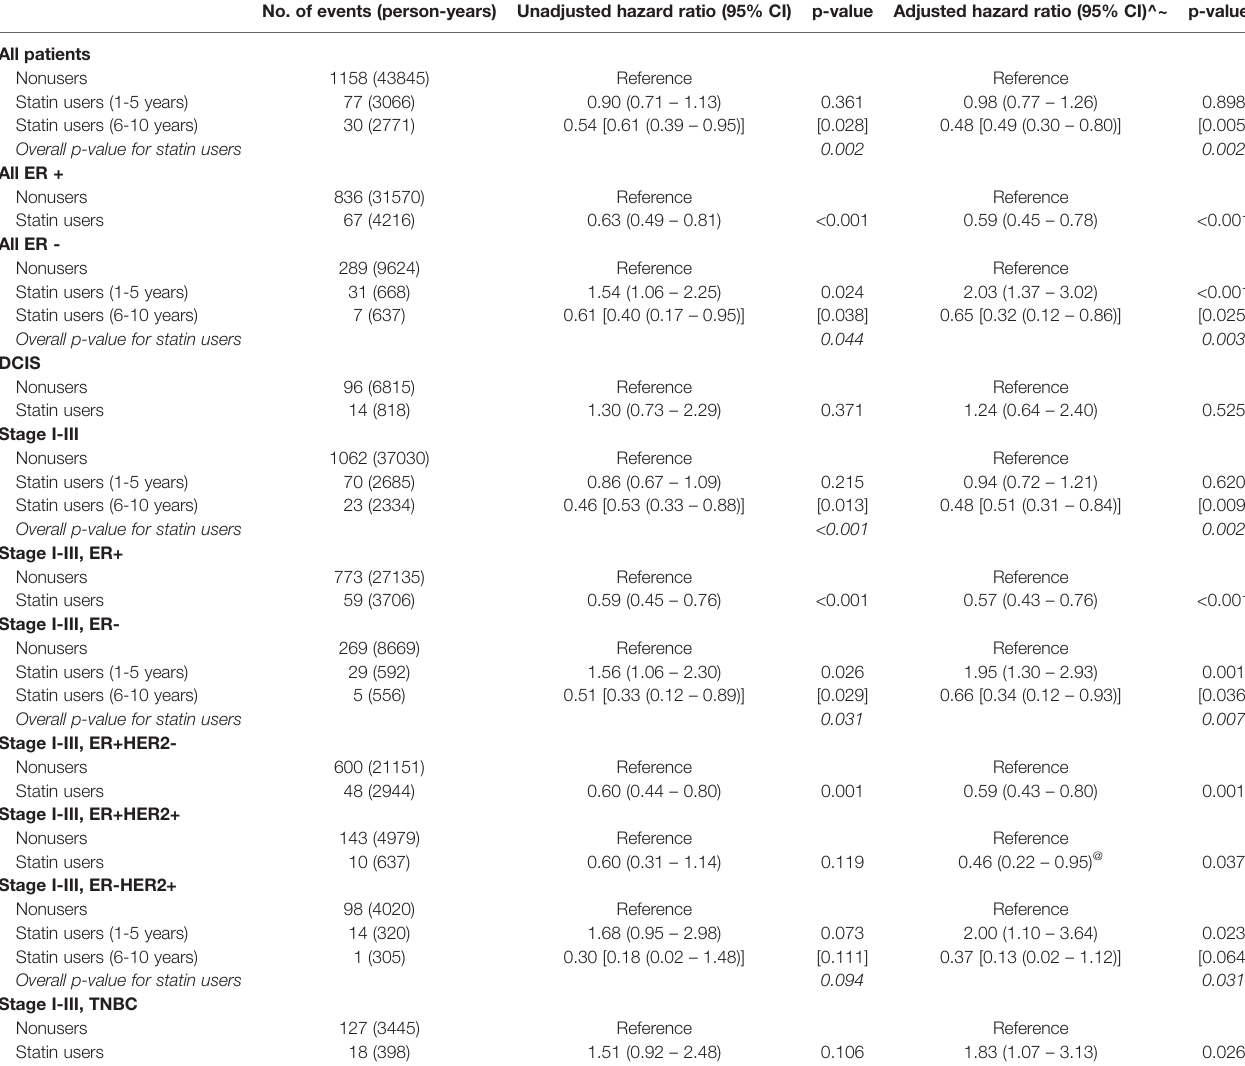
TABLE 2 | Unadjusted and adjusted hazard ratios for breast cancer recurrence by statin use in different subsets of patients. No. of events (person-years) Unadjusted hazard ratio (95% CI) p-value Adjusted hazard ratio (95% CI)^~ p-value~ All patients